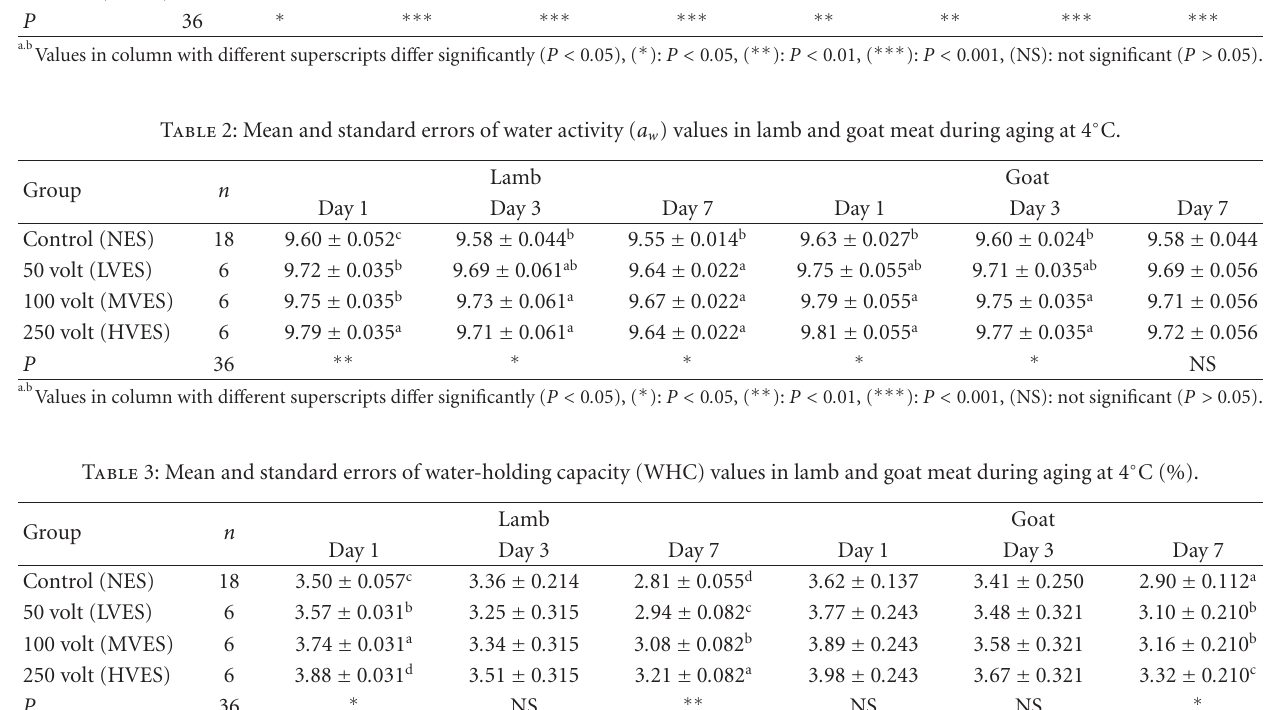
Table 1: Mean and standard errors of pH values in lamb and goat meat during aging at 4 ◦ C. Lamb Goat Group n 1h 3h Control (NES)